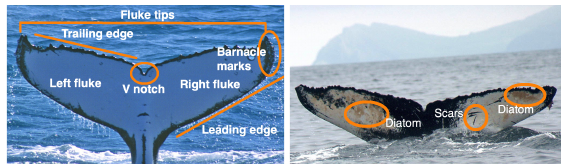
Figure 1. Important characteristics of a whale